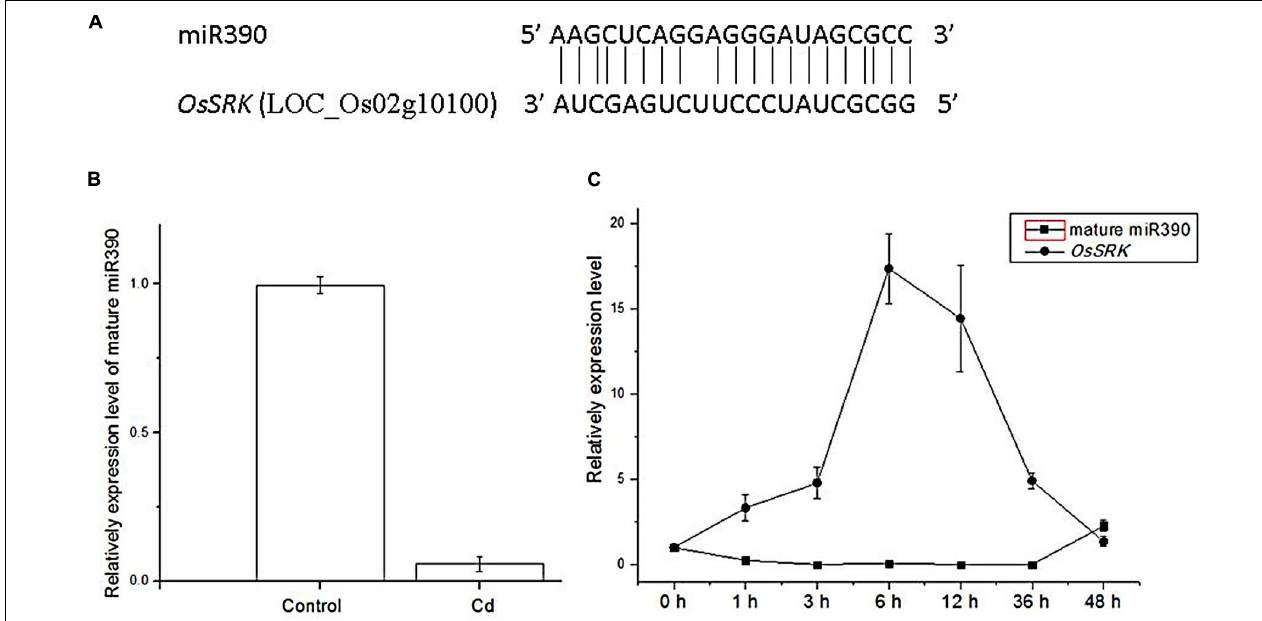
FIGURE 1 | Expression levels of miR390 and its target gene OsSRK as detected by qPCR. (A) Sequence alignment of miR390 and OsSRK . The matched base pairs are indicated by a vertical line. (B) Detection of the transcript of mature miR390 expression from 2-weeks-old rice seedlings treated with 60 µ M CdCl 2 for 6 h by qPCR. U6 gene was used as the inner control. (C) QPCR analysis of the mature miR390 and OsSRK transcript levels in roots of 2-weeks-old rice seedlings treated for the indicated times with 60 µ M CdCl 2 . Quantifications were normalized to the expression of OsACTB . Error bars represent the SE for three independent experiments.